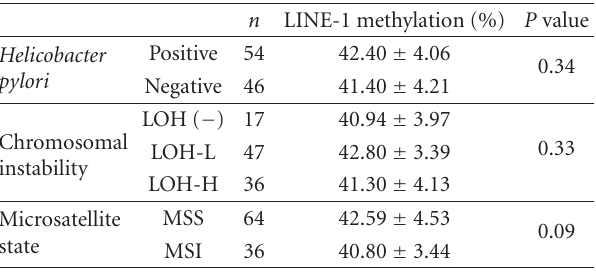
Table 1: LINE-1 methylation level according to H. pylori infection and genetic instability (chromosomal instability and microsatellite instability) in gastric epithelial